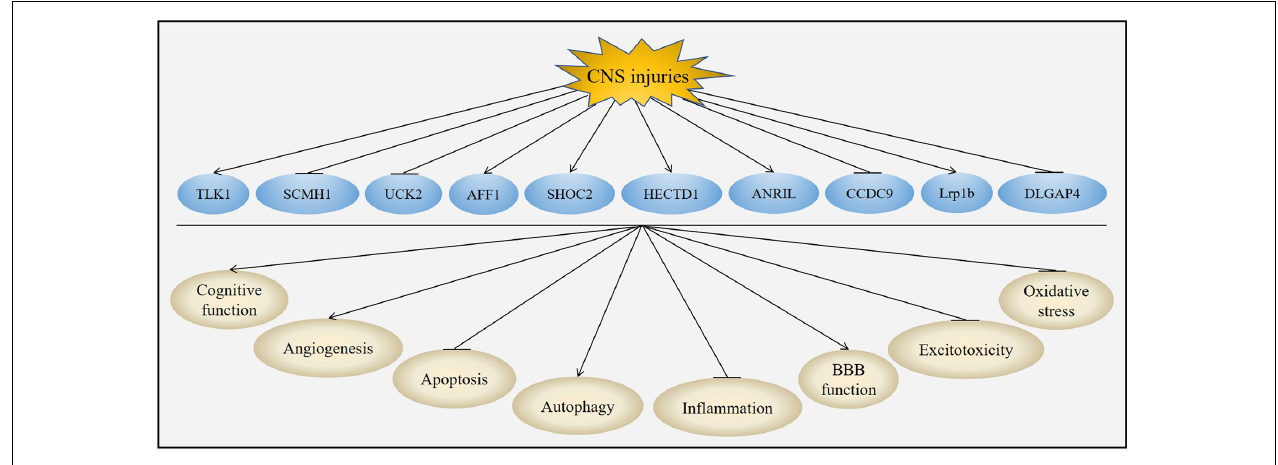
FIGURE 5 | Role of circRNAs in acute CNS injuries. CNS injuries up-regulated the expression of TLK1, AFF1, SHOC2, HECTD1, ANRIL and Lrp1b while down-regulated the expression of SCMH1, UCK2, CCDC9 and DLGAP4. Changes of these circRNAs could improve cognitive function, promote angiogenesis, activate autophagy, protect BBB function, suppress apoptosis, inhibit inflammation, attenuate excitotoxicity and reduce oxidative stress post-CNS injuries.